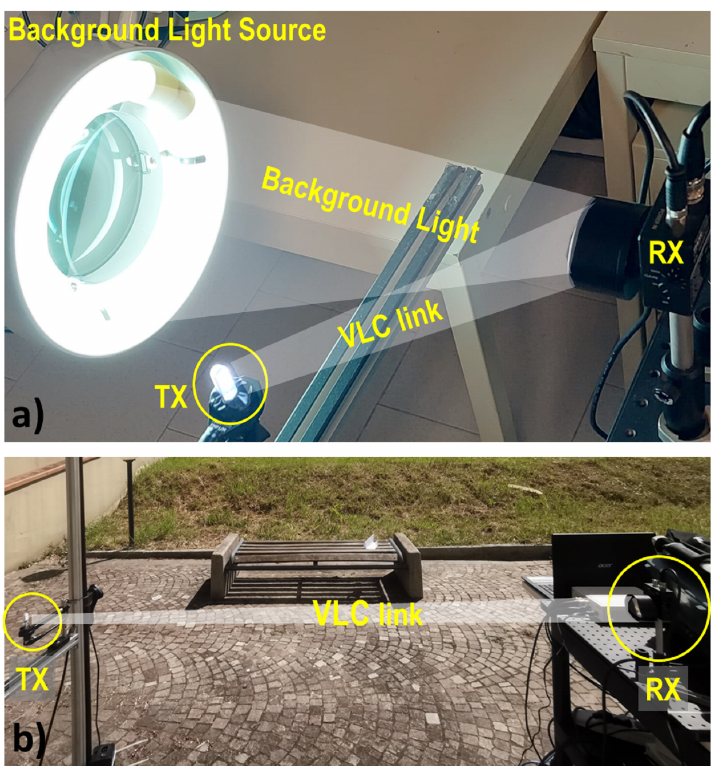
Figure 2. Experimental setups used: ( a ) Indoor measurements in the presence of strong background light, ( b ) outdoor measurements setup under strong solar